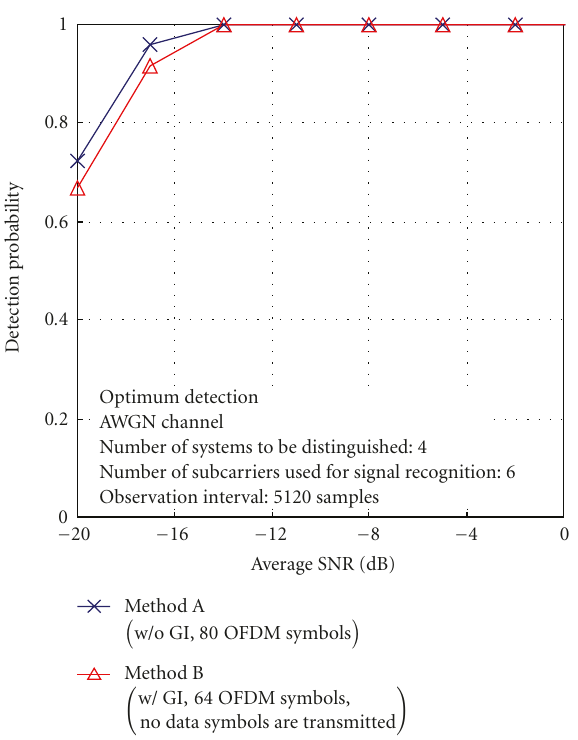
Figure 13: Comparison of detection performance of Methods A and B for the same amount of